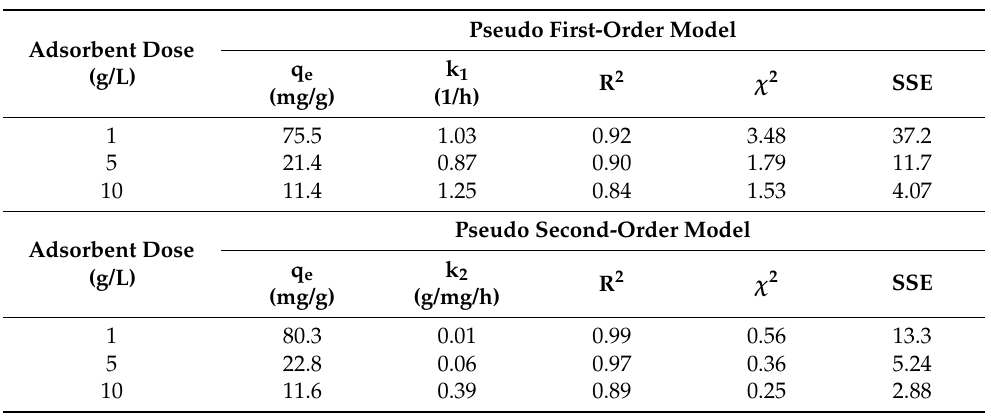
Table 3. Kinetic model parameters obtained from model fitting to experimental data.